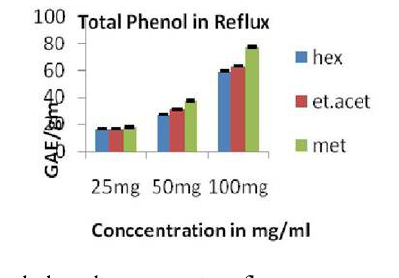
Fig. 7. Total phenolic content in reflux